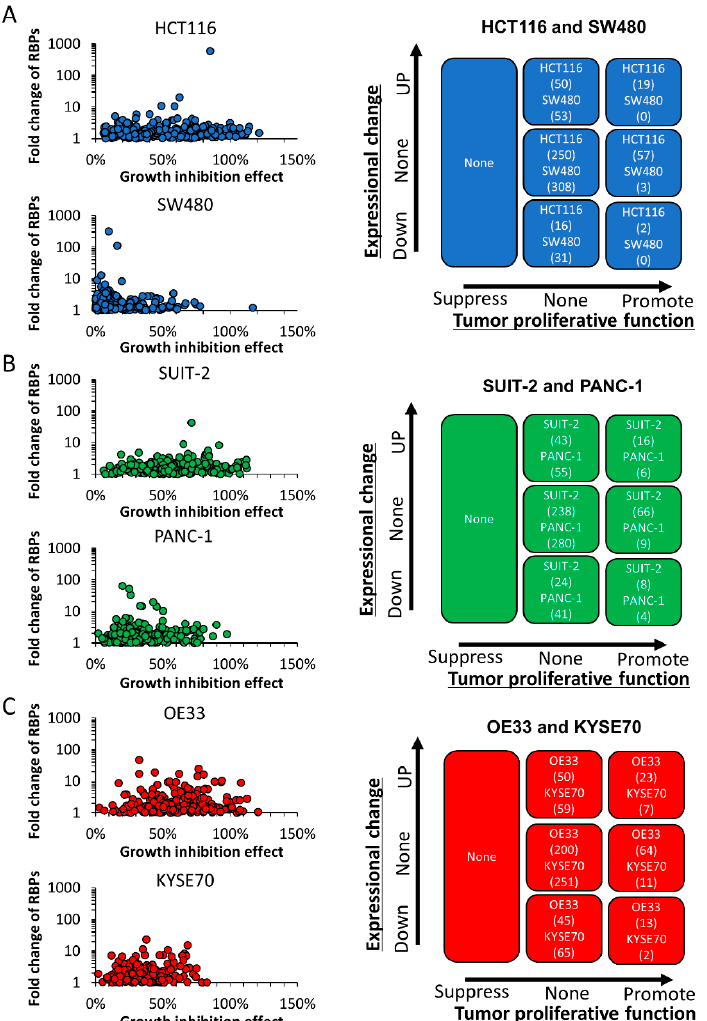
Figure 2. The assessment of the correlation of the functional and expressional significance in cancer cells. The correlation of the growth-promotive effect and expressional significance of RBPs was assessed by an SRB assay and cDNA microarray analysis in colorectal cancer cells ( A ), pancreatic cancer cells ( B ) and esophageal cancer cells ( C ). The number of genes is described for each cell. The tumor-proliferative function was evaluated according to the following criteria: tumor-promotive RBPs, RBPs with a >50% growth reduction effect; tumor-suppressive RBPs, RBPs with a >50% promotion effect. Likewise, the mRNA expression changes were classified according to the following criteria: upregulated RBPs, RBPs over-expressed in cancer cells ( ≥ 2-fold change); downregulated RBPs, RBPs with a decreased expression in cancer cells ( ≥ 2-fold change).